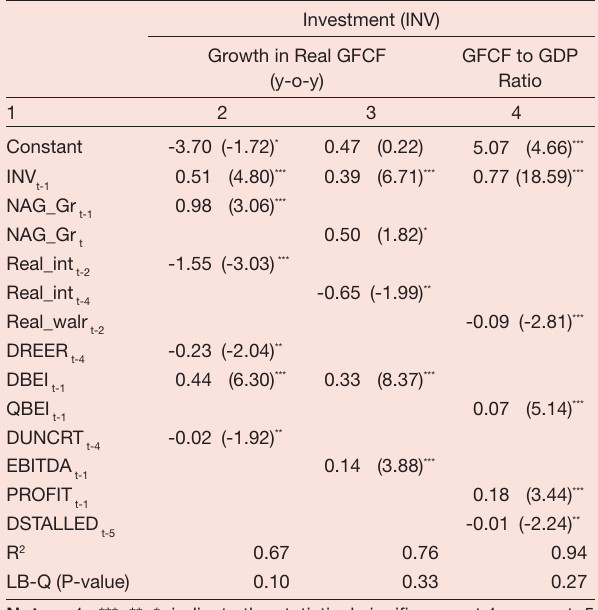
Table 1: Factors that Influence the Investment climate Investment